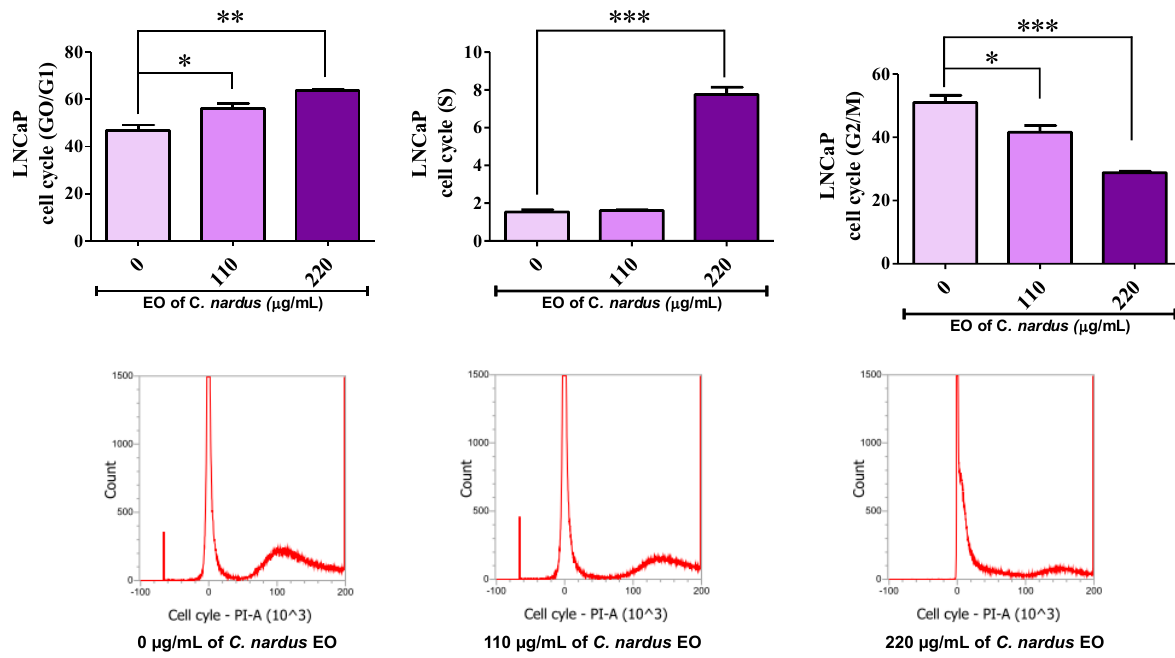
Bayala et al. , Figure 6.